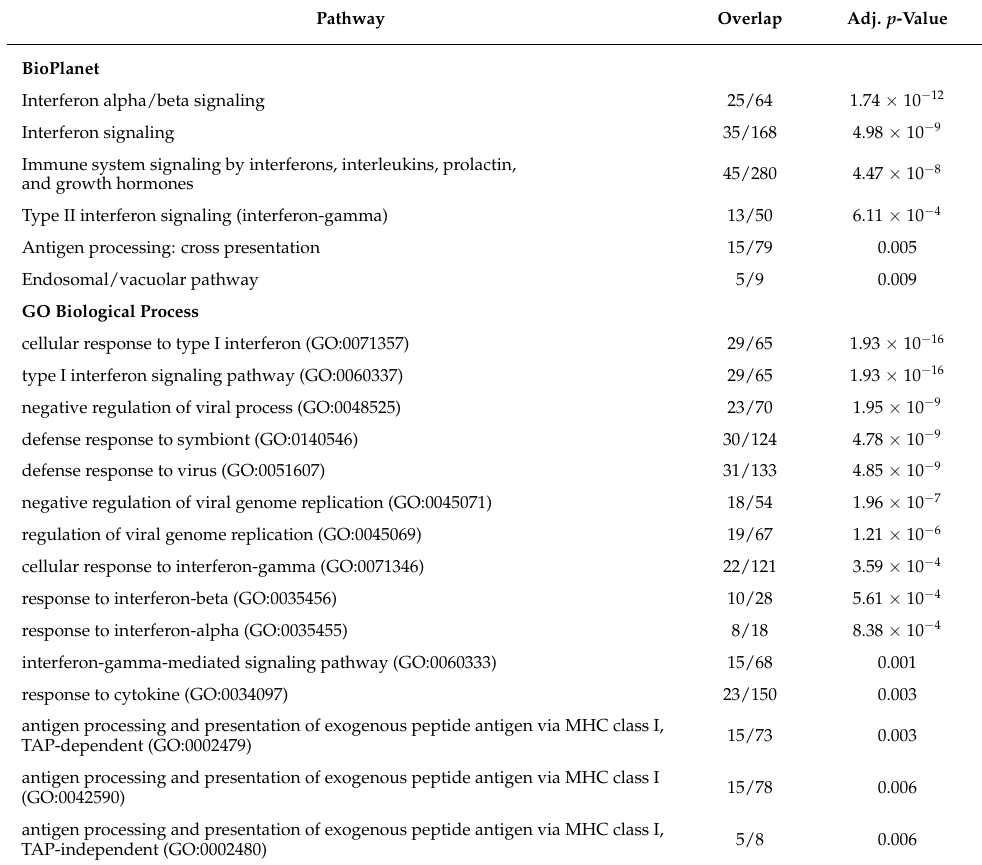
Table 3. Pathway enrichment analysis (Enrichr) of DRGs between VECs cultured in CM miR193a vs. CM mimic CTR.